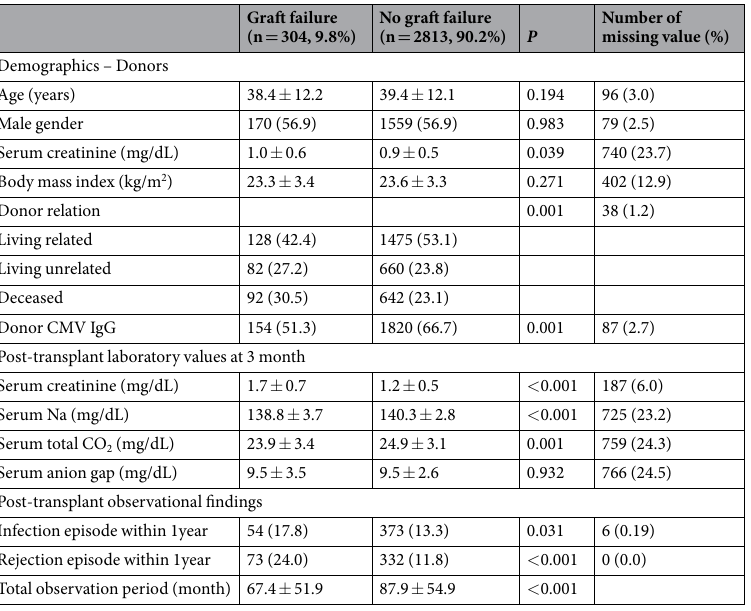
Table 2. Baseline characteristics of kidney donors and post-transplant findings according to graft survival in kidney transplants recipients (KTRs). Abbreviations: ESRD, end-stage renal disease; GN, glomerular nephritis; RRT, renal replacement therapy; ABOi, ABO incompatible; HBsAg, Hepatitis B virus surface antigen; HCV Ab, hepatitis C virus antibody; CMV IgG, cytomegalovirus immunoglobulin G; PRA, panel reactive antibody; HLA, human leukocyte antigen.